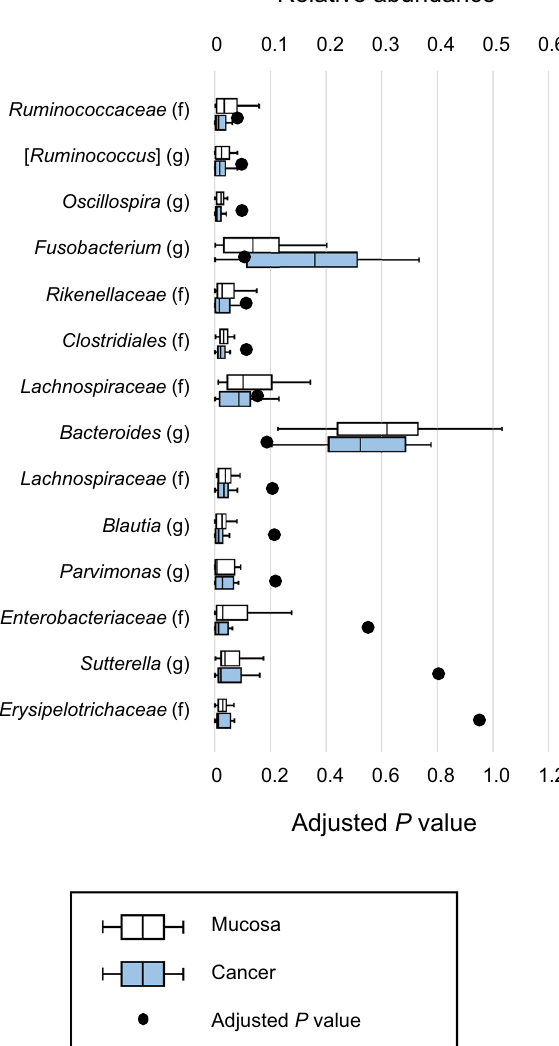
Figure 5. Comparisons of relative abundance in the mucosa after washing and the cancer tissue after washing at up to the genus level by boxplot. Whiskers are extended to the most extreme data point, which is no greater than 1.5 × the interquartile range from the edge of the box in the boxplot. Statistical significance was determined using the Wilcoxon signed-rank test. The Benjamini–Hochberg method for controlling the false-discovery rate was used for multiple